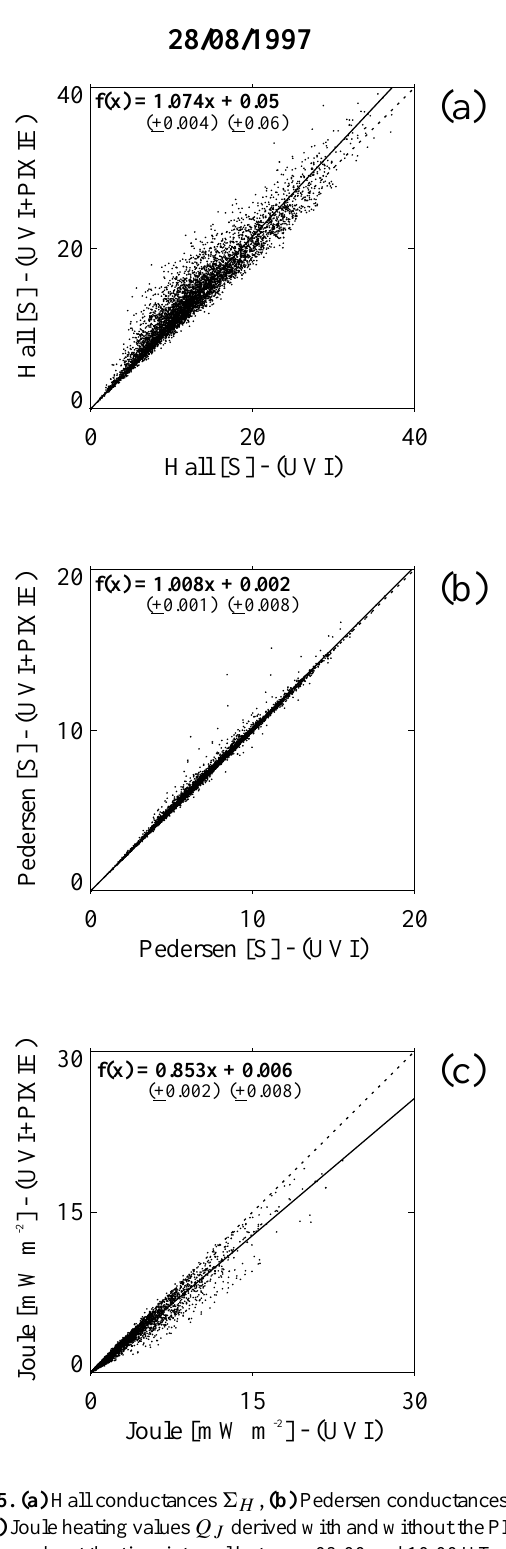
Fig. 15. (a) Hall conductances 6 H , (b) Pedersen conductances 6 P and (c) Joule heating values Q J derived with and without the PIXIE data throughout the time interval between 03:00 and 10:00 UT on 28 August, 1997. The data values are taken from the regions covered by the PIXIE and UVI instruments. The solid line results from a linear regression analysis of the data